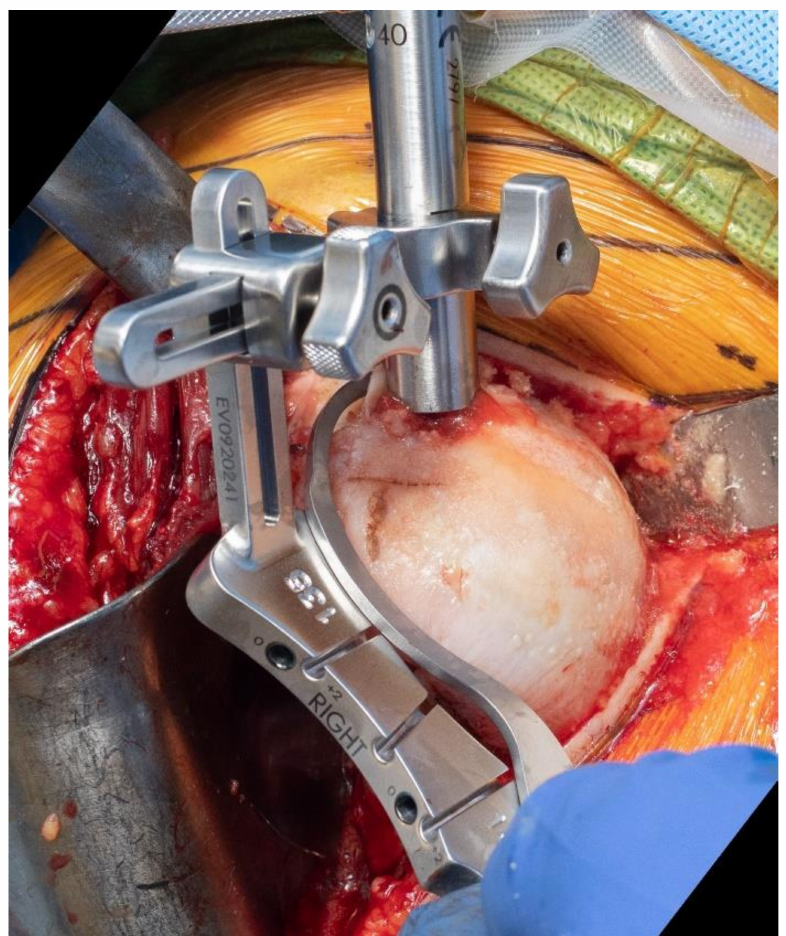
Figure 7. Use of an extramedullary cutting guide may facilitate predictable osteotomy of the humerus in a specific degree of inclination.